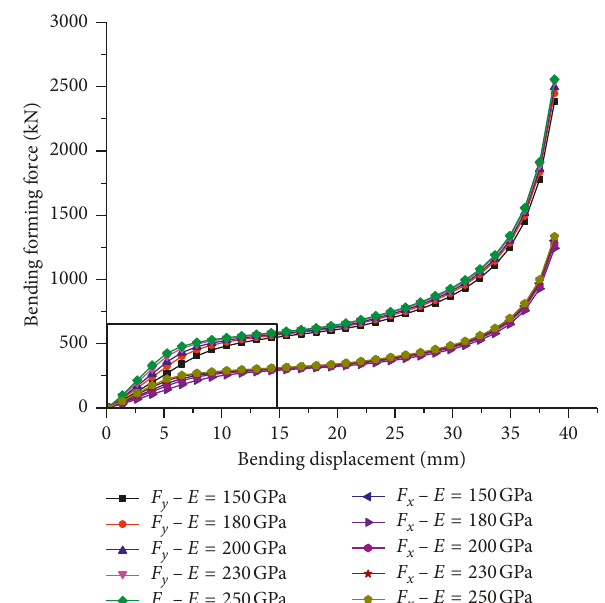
Figure 3: Effects of the elastic modulus on the bending